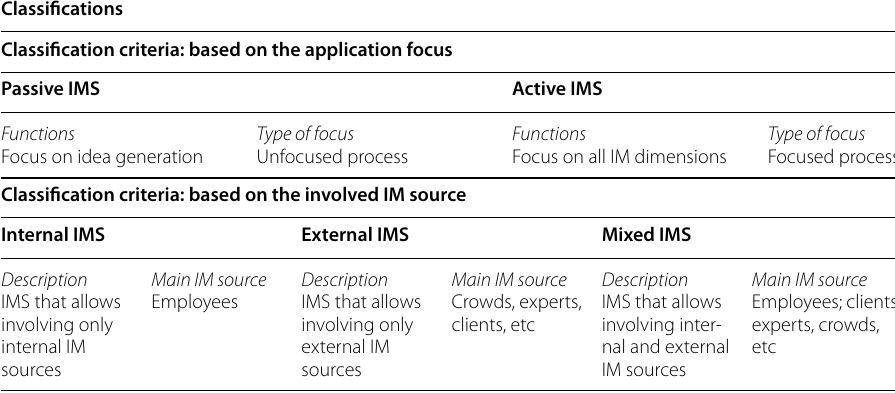
Table 2 Idea management types. Source: developed by the authors based on Mikelsone et